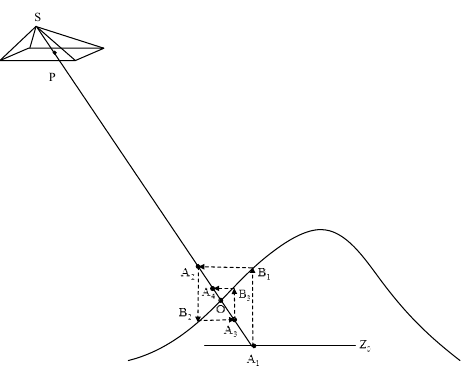
Figure 5. Iterative photogrammetric algorithm [58].